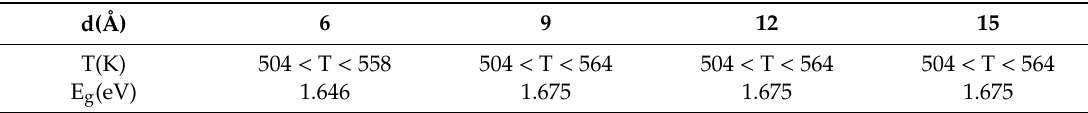
Table 2. Electron density for materials poly(C 13 H 8 OS–H) with energies and thickness of layers di ff erent in the